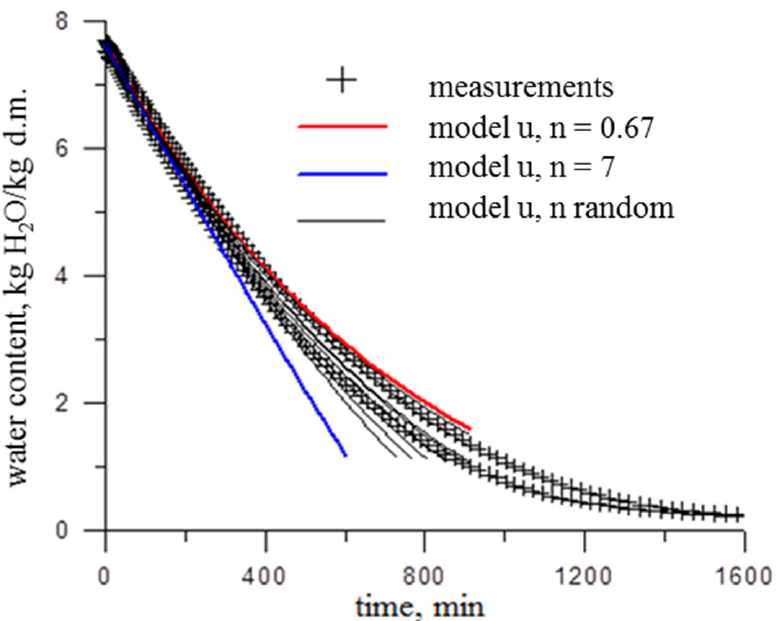
Figure 6. The graphs of models for moisture content changes with random coefficient for leek slices 8 mm thick, during drying at temperature 40 °C.